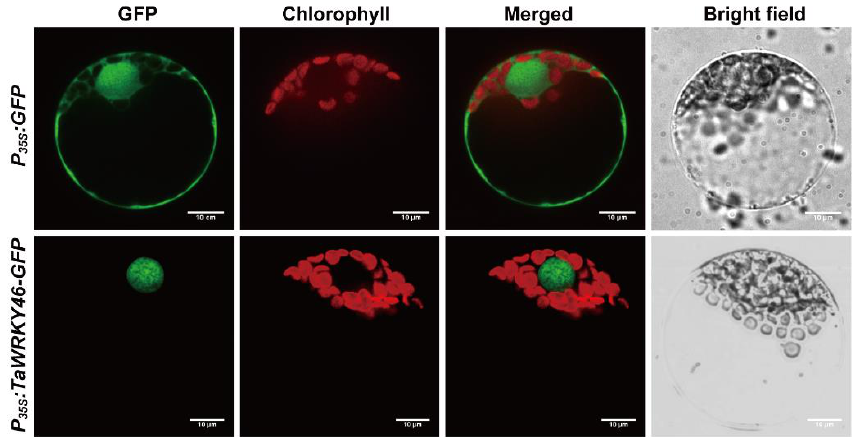
Figure 3. Subcellular localization of the TaWRKY46 . P 35S :TaWRKY46-GFP and P 35S :GFP control vectors were transiently expressed in wheat leaf protoplasts. Scale bar = 10 μm.